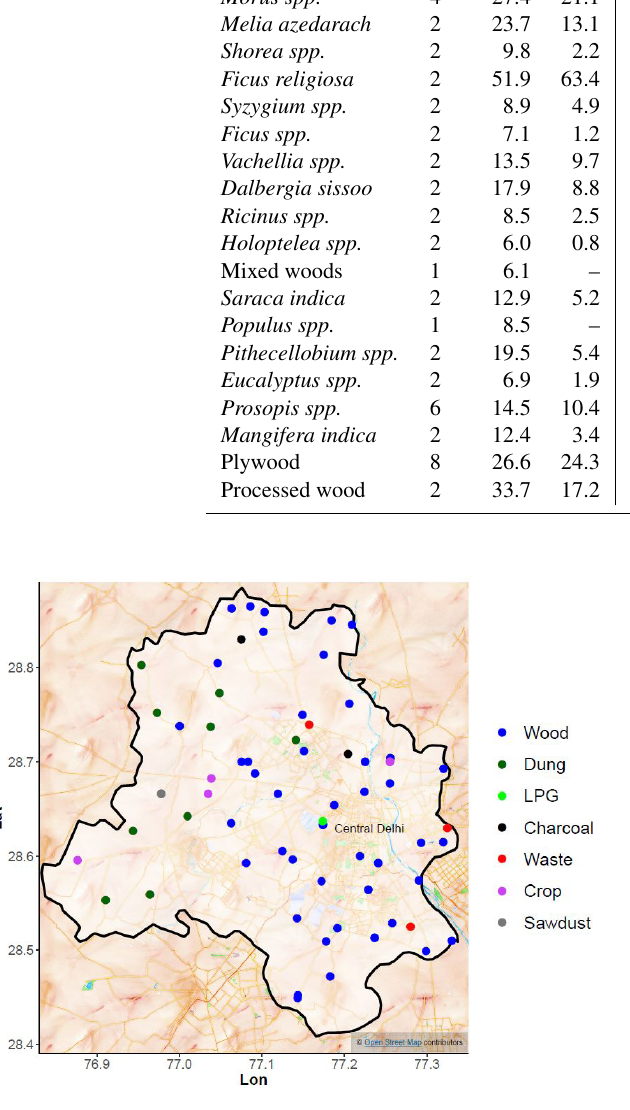
Figure 1. Locations across Delhi used for the local surveys of fuel use and collection of representative biomass fuels. Map tiles